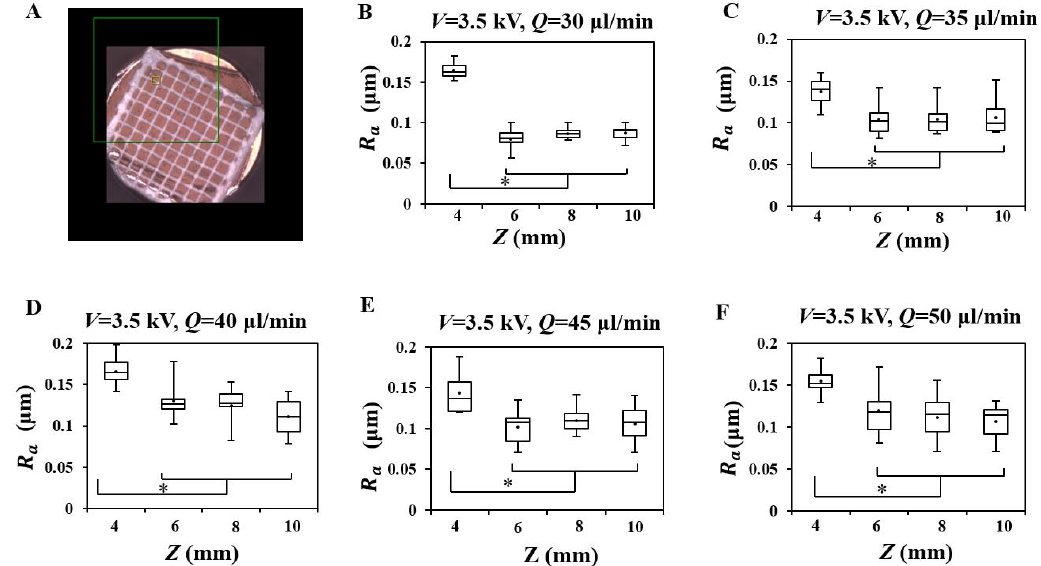
Figure 5. ( A ) Photo of EHD direct-written patterns ( 10 × 10 mm square). Roughness ( 𝑅 𝑎 ) at different Z when V was set at 3.5 kV and Q was set at ( B ) 30 μl/min, ( C ) 35 μl/min, ( D ) 40 μl/min, ( E ) 45 μl/min, and ( F ) 50 μl/min (* represents p < 0.01).